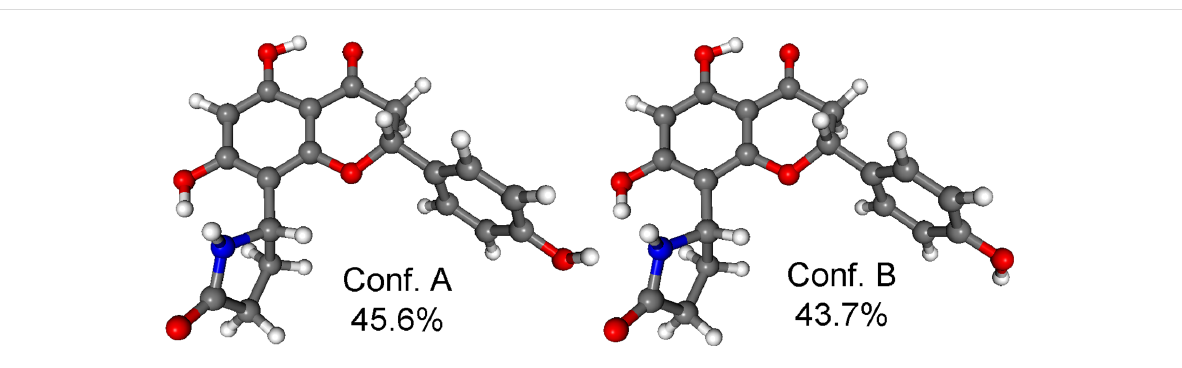
Figure 11: Structure and population of the low-energy CAM-B3LYP/TZVP PCM/MeCN conformers (>2%) of (2 R ,5’’ S )- 3b .